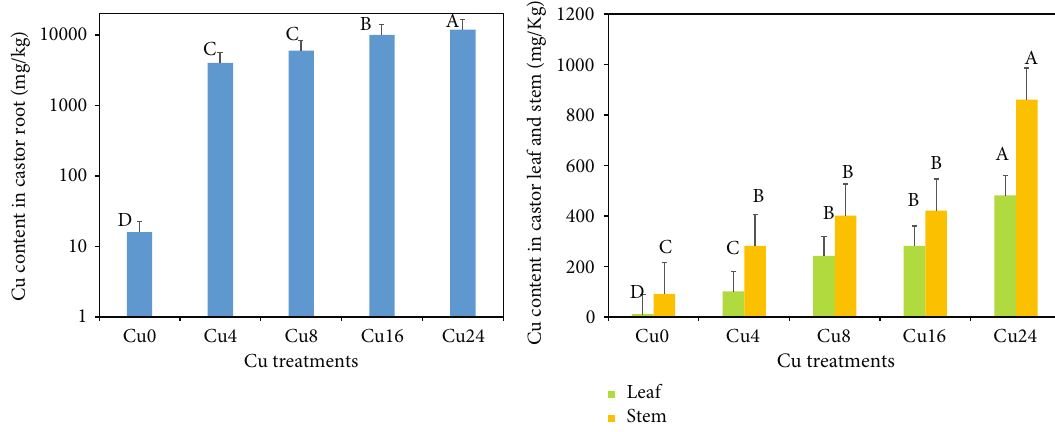
Figure 5: Cu content in di ff erent parts of willow after Cu